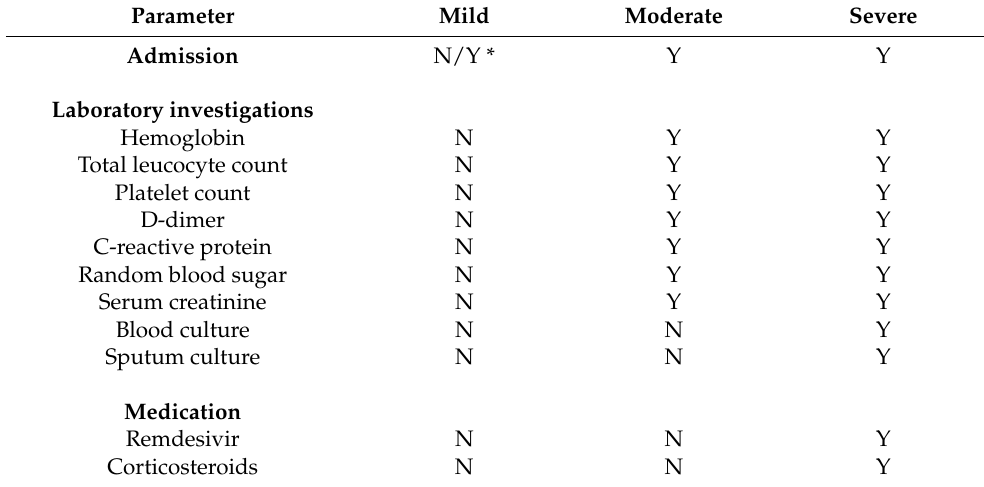
Table 1. Guidelines on admission, laboratory investigations and medications (stratified by severity of the COVID-19 illness) followed in a tertiary hospital of Nepal during April to September